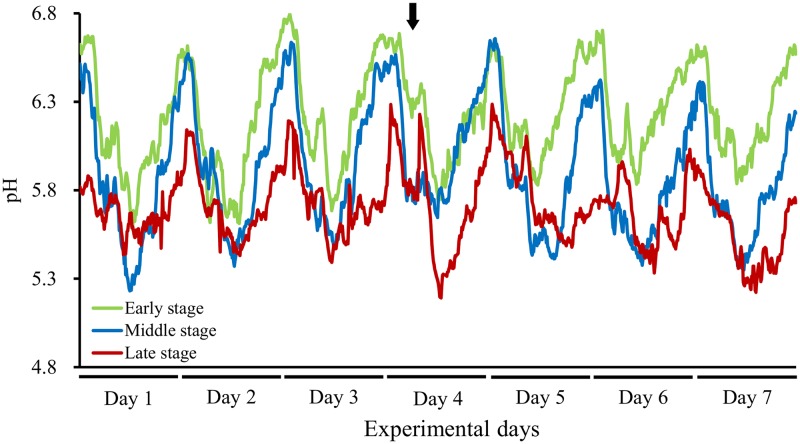
Diurnal changes in the 10-minute mean ruminal pH in Japanese Black beef cattle.Days 1–7 correspond to observations made during the final 7 days of each fattening stage. Arrows indicate the sample collection time (1300 h).